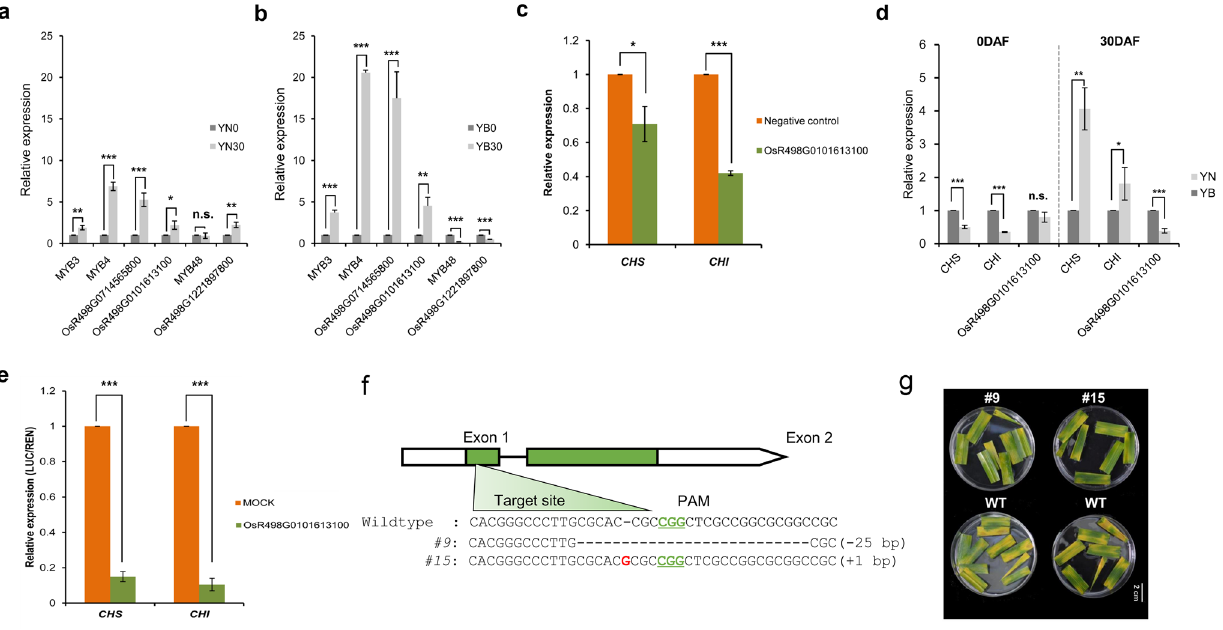
Figure 5. Expression regulation and anti-senescence analyses of MYB TFs. ( a ) qRT-PCR validation of MYB TFs in the YN0 versus YN30 comparison. ( b ) qRT-PCR validation of MYB TFs in the YB0 versus YB30 comparison. ( c ) qRT-PCR results of endogenous CHS and CHI genes in protoplasts transfected with OsR498G0101613100 . Statistical analysis was performed using Student’s t-test: *, P < 0.05; **, P < 0.01; ***, P < 0.001; n.s. not significant. ( d ) qRT-PCR validation of OsR498G0101613100 , OsCHS and OsCHI between YN and YB. ( e ) Promoter activity analysis shows that OsR498G0101613100 significantly suppresses